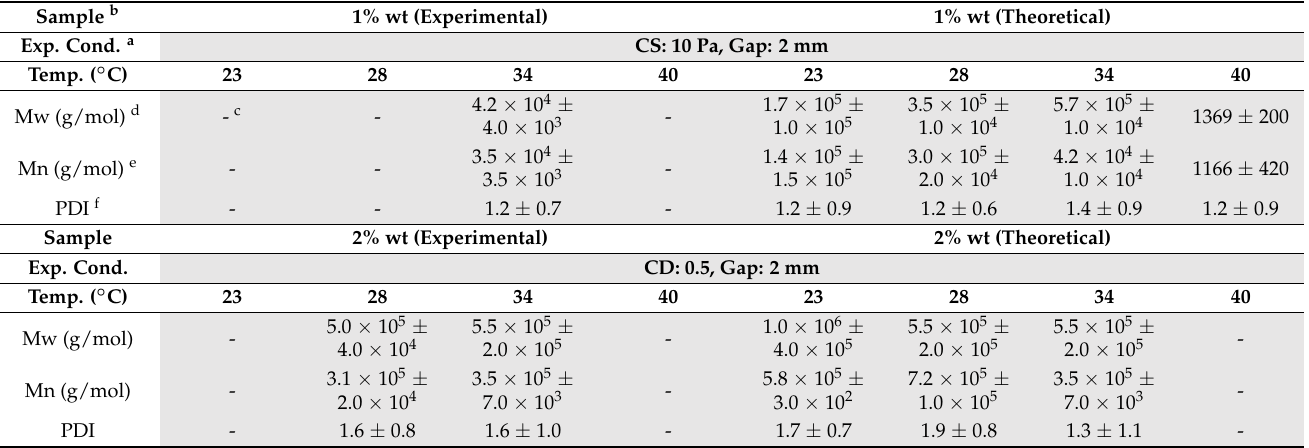
Figure 4. Gel-like behavior of 1% wt diluted samples at low temperatures of ( a ) 23 °C and ( b ) 28 °C . As the concentration of the studied samples was increased, the linear viscoelastic range was broader and a larger gap of experimental conditions, within the linear viscoe- lastic regime, could be used for the oscillatory tests. However, as shown in Table 2, as the concentration of the samples increased, the motion constraints decreased the T d , so that (as shown in Table 3) the reported molecular weights were more reproducible and con- sistent only at low temperatures, within the linear viscoelastic range and when data fitting was applied, for samples between 3% wt and 5% wt. Table 3. Molecular weights and their polydispersity index for samples with different concentra- tions .